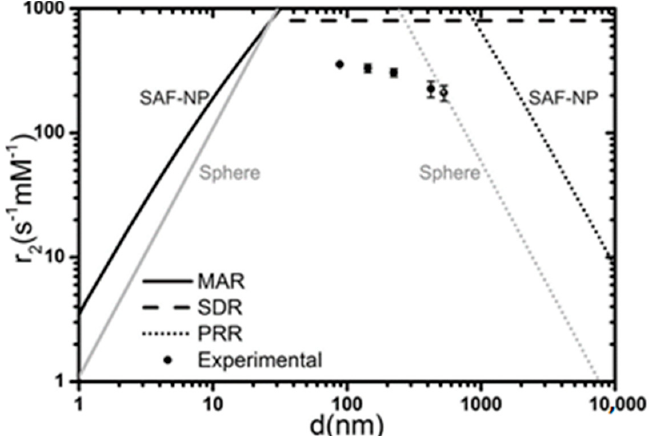
Figure 16. Variation of both the theoretical (dark lines) and the measured (points) r 2 values associated with [Au (10 nm)/NiFe (10 nm)/Au (2.5 nm)/NiFe (10 nm)/Au (10 nm)] SAF-NPs in terms of diameter. For benchmarking purposes, the theoretical values for NiFe nanoparticles are represented in